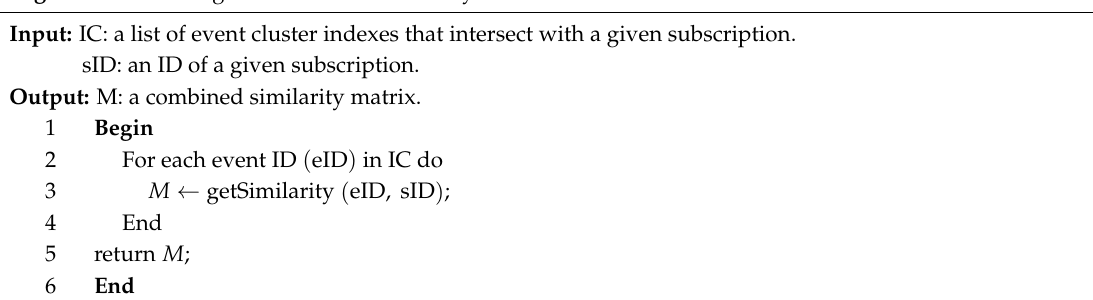
Algorithm 3 Building the Combined Similarity